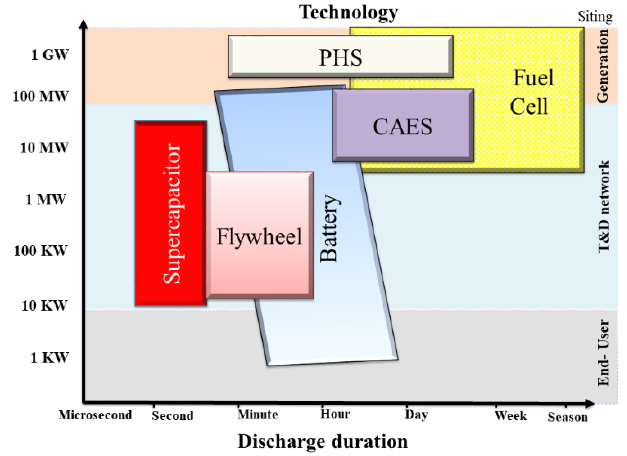
Figure 4. The categorization of ESS technologies using the power capacity of income, outcome, and discharge duration time.